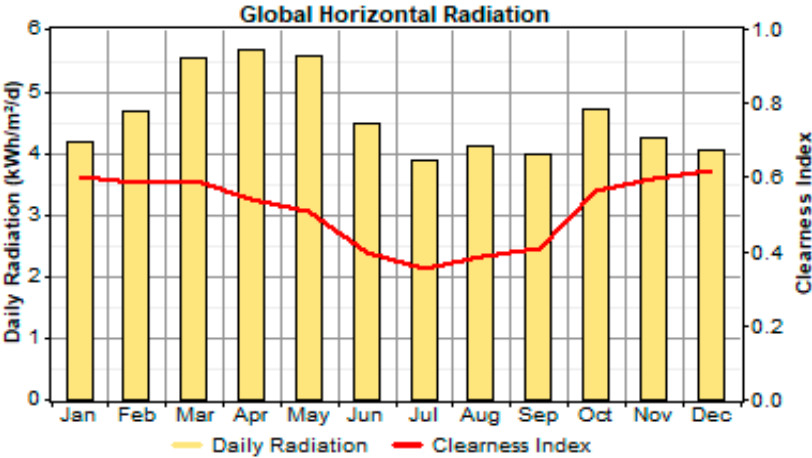
Figure 2. Average daily solar radiation and clearness.